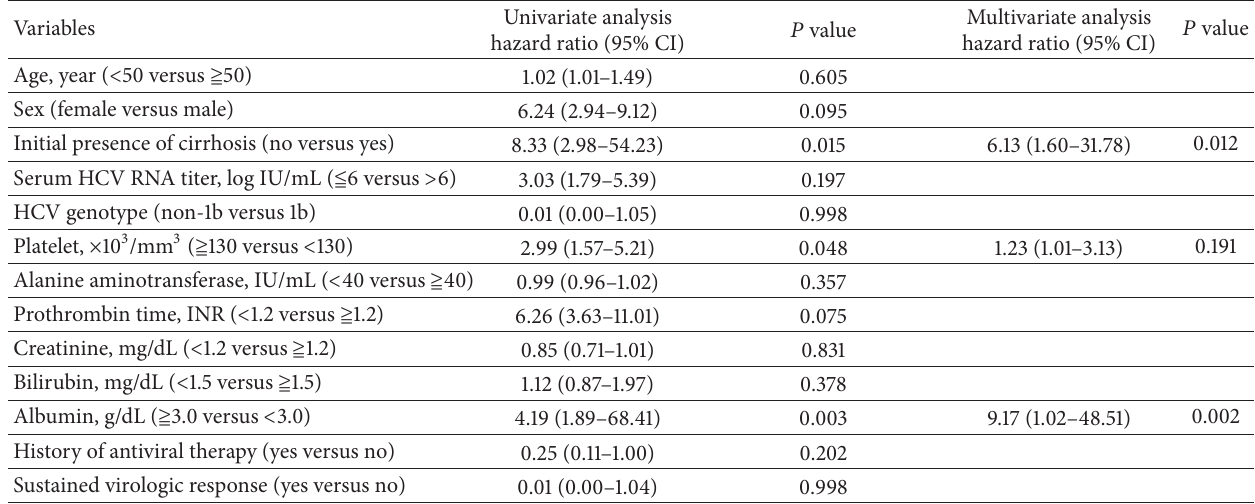
Table 4: Analysis of variables associated with liver-related mortality.